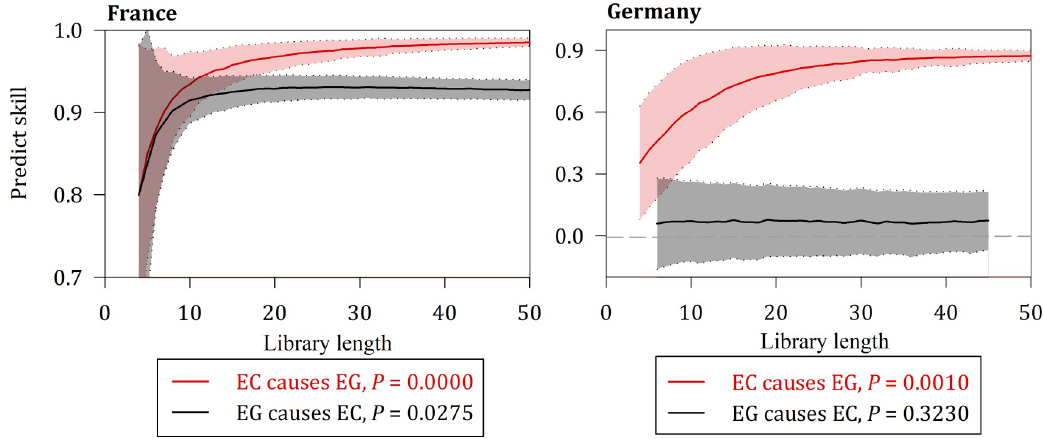
Fig 6. Causality between EC and EG for France and